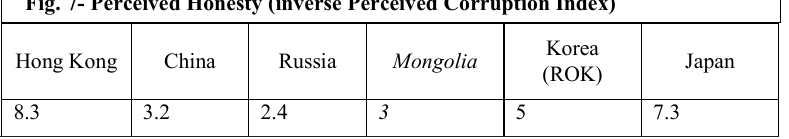
Fig. 7- Perceived Honesty (inverse Perceived Corruption Index)